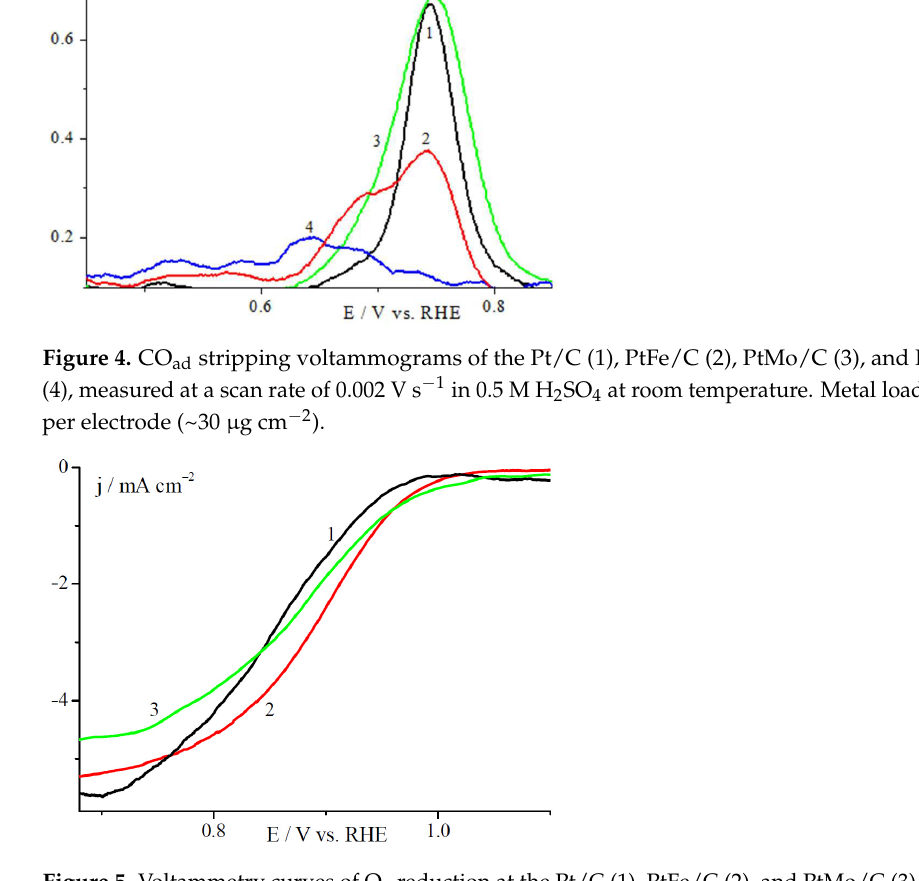
Figure 5. Voltammetry curves of O 2 reduction at the Pt/C (1), PtFe/C (2), and PtMo/C (3) samples in O 2 saturated 0.5 M H 2 SO 4 , at atmospheric pressure and room temperature. Metal loading is 2 µ g per electrode (~30 µ g cm − 2 ). Potential scan rate is 0.005 V s − 1 . The electrode rotation rate is 2500 rpm.